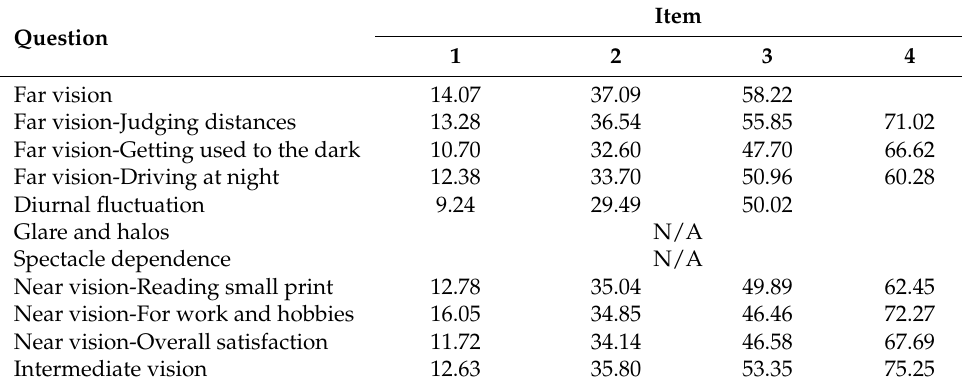
Table 7. Patients in the monofocal group were more spectacle dependent for near vision compared with the bifocal and EDOF group ( p < 0.001). Table 4. Item score after Rasch transformation (scale, 0–100).